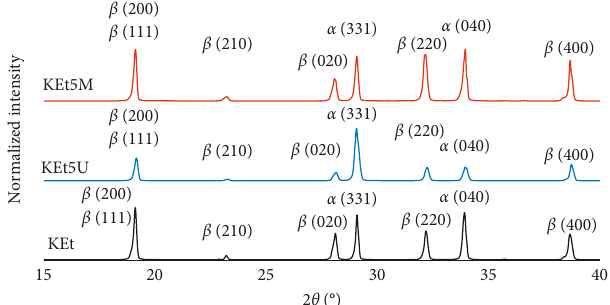
Figure 7: X-rays diffraction patterns for the KEt5M, KEt5U, and KEt